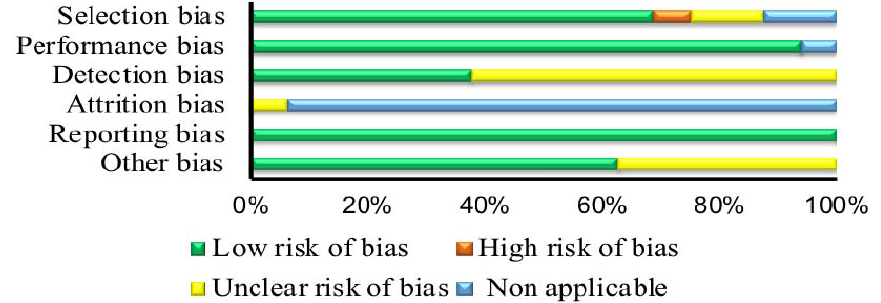
Figure 2. Summary of risk of bias assessment for non-randomized controlled trials. Selection bias, high risk ( n = 1), low risk ( n = 11), unclear risk ( n = 2), non-applicable ( n = 2); Performance bias, low risk ( n = 15), non-applicable ( n = 1); Detection bias, low risk ( n = 6), unclear risk ( n = 10); Attrition bias, unclear risk ( n = 1), non-applicable ( n = 15); Reporting bias (selective reporting, low risk ( n = 16)); Other bias (confounding, low risk ( n = 10), unclear risk ( n = 6)).